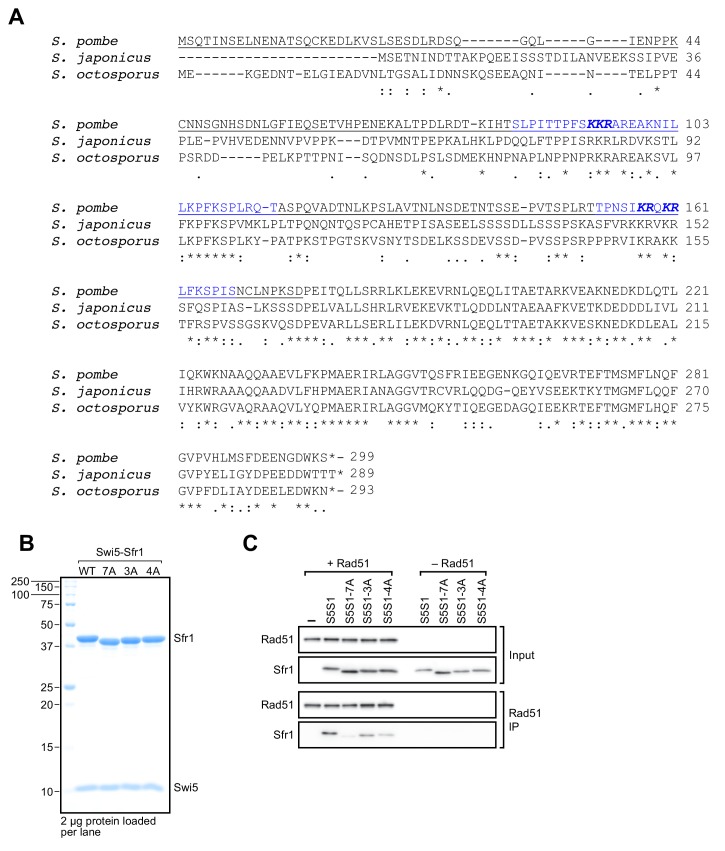
Identification of residues within sites 1 and 2 that are important for the functional interaction with Rad51.(A) Sequence alignment of Sfr1 homologs from the genus Schizosaccharomyces were generated with Clustal Omega. S. pombe Sfr1N (residues 1–176) is underlined, with Sites 1 and 2 shown in blue. Bold italic typeface indicates consecutive positively charged residues that were targeted for mutation. (B) CBB-stained gel of purified Swi5-Sfr1 (wild type and mutants). 7A has mutations in all bold residues from (A), whereas 3A and 4A only contain mutations in bold residues from Sites 1 and 2, respectively. Size markers are annotated on the left in kDa. Note that Sfr1 migrates slower than expected from its calculated molecular weight (~33.6 kD), as previously reported (Haruta et al., 2006). This property is attributable to its N-terminal half (Kuwabara et al., 2012), hence why mutation of residues in Sites 1 and 2 affects its electrophoretic mobility. (C) Rad51 was mixed with Swi5-Sfr1 (S5S1, wild type or mutants; input), complexes were IP'd with anti-Rad51 antibodies and the contents of these IPs were assessed by immunoblotting. ‘–" indicates the omission of Swi5-Sfr1.